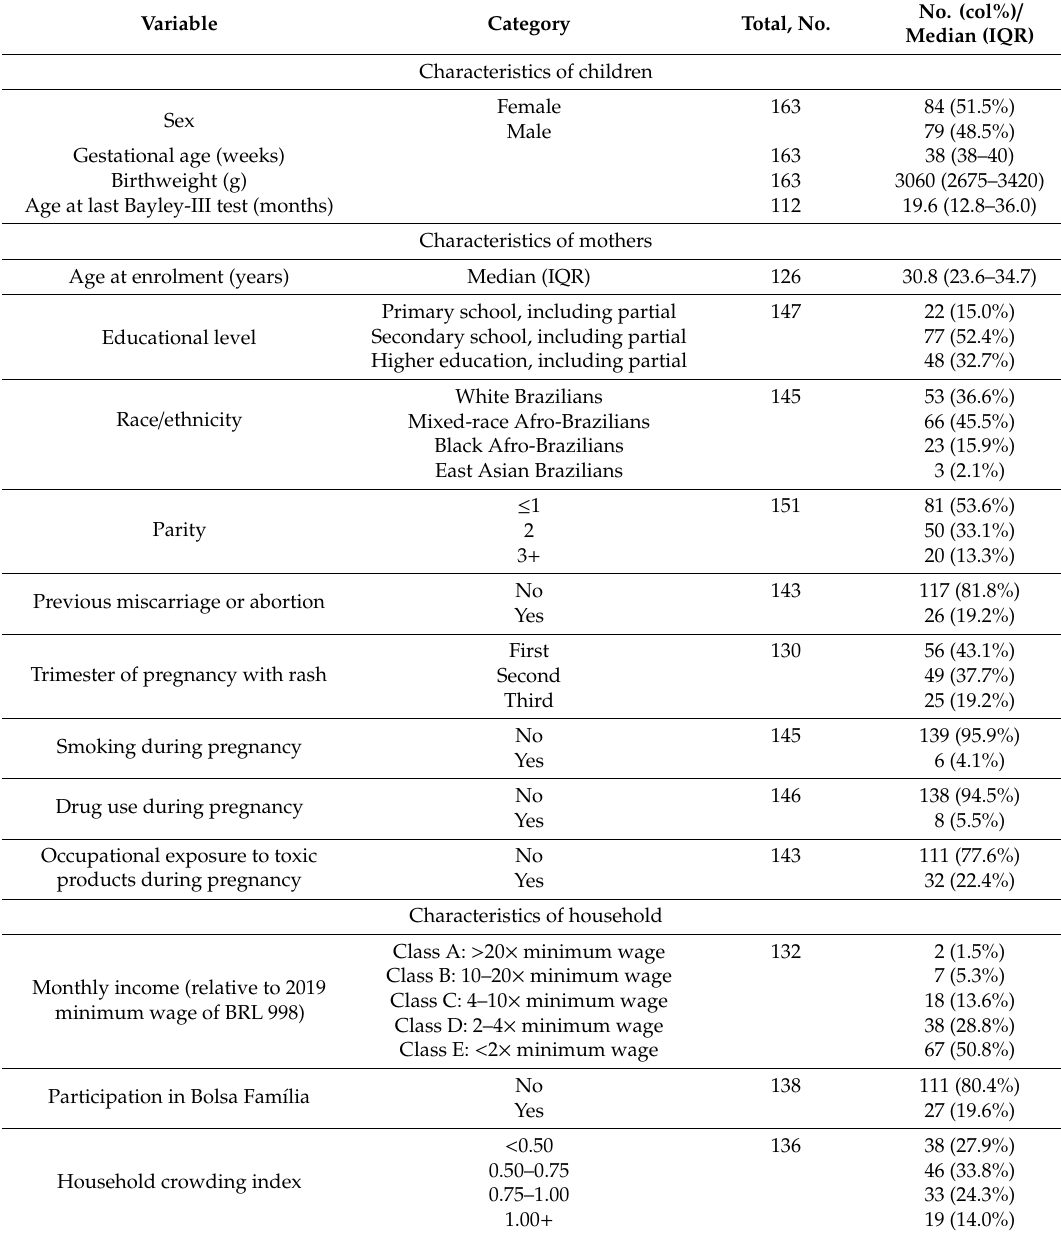
Table 1. Baseline distribution of selected cohort characteristics ( n =